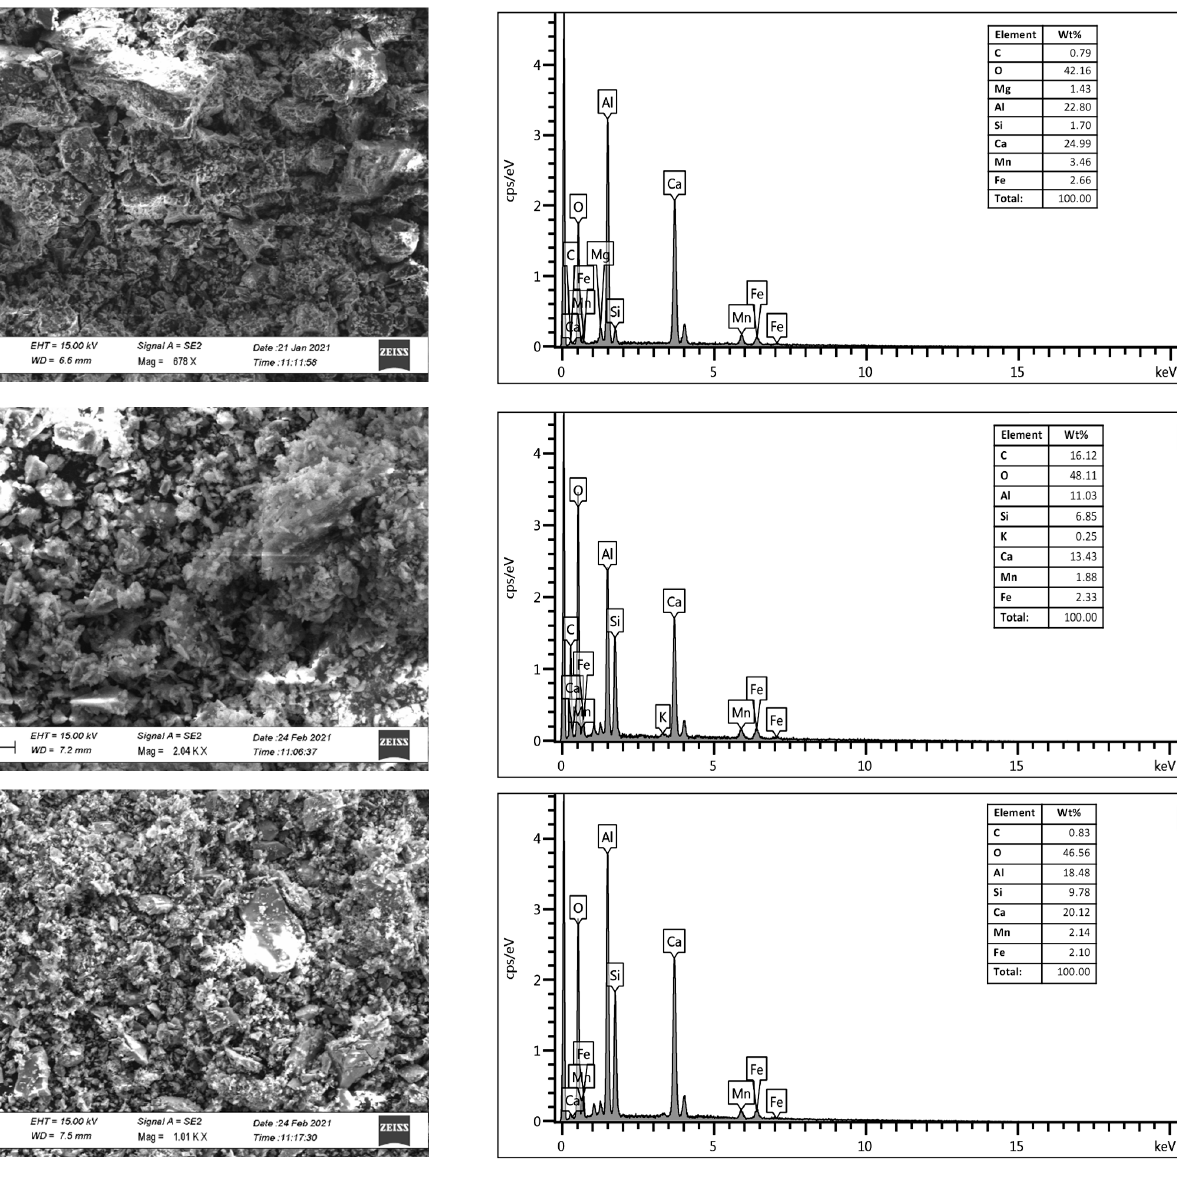
Figure 2. SEM EDX analyses of catalysts 1 ( A ) before catalytic reactions, ( B ) after the fourth cycle, and ( C ) after the fourth cycle and thermal treatment (400 ◦